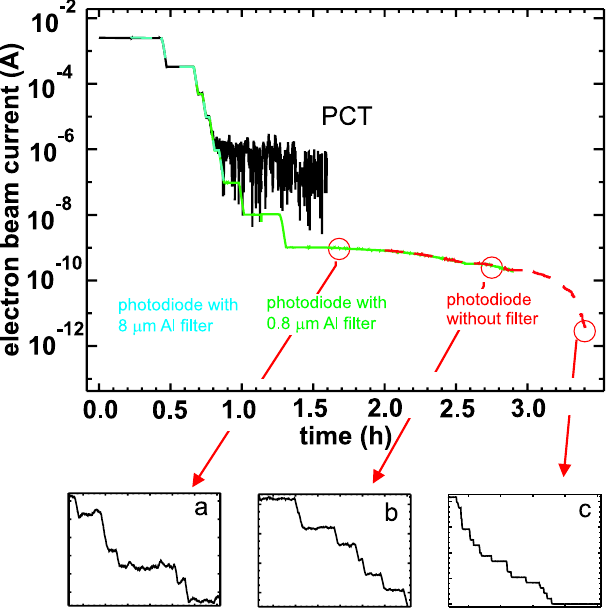
FIG. 12. (Color) Controlled reduction of the electron beam current from some mA to a single electron.